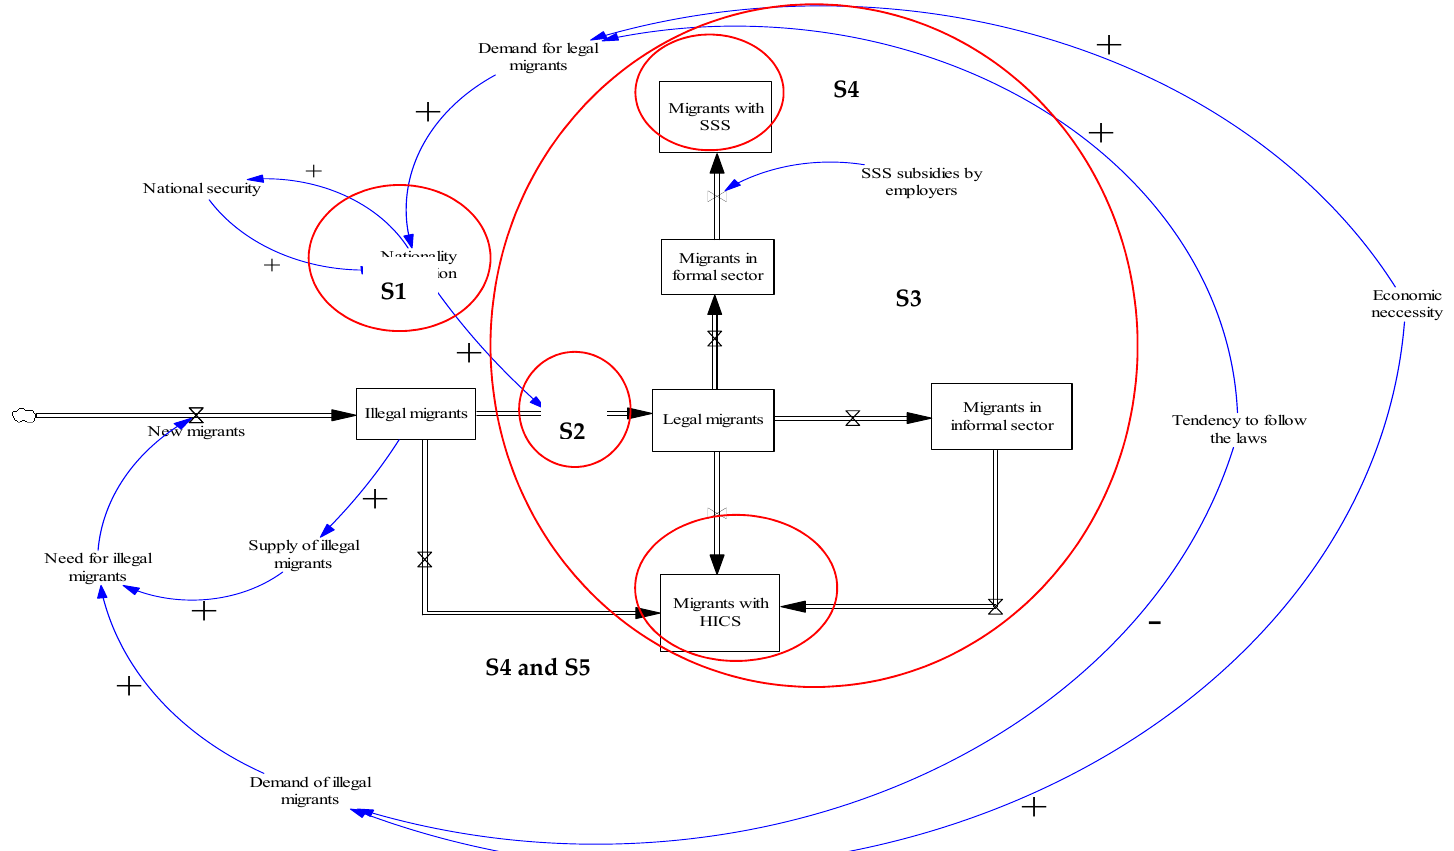
Figure 3. The SFD of the dynamics of the legalisation process and access to health insurance (SSS and HICS) by migrant workers. Note: Subtheme 1: NV process as the most critical step for legalising the precarious status of undocumented migrants. Subtheme 2: Role of private hospitals in health examination before enrolling in the insurance. Subtheme 3: Interim period between enrollment in the SSS and e ff ective activation of insurance. Subtheme 4: Practical problems originating from the di ff erence in the design between the SSS and the HICS. Subtheme 5: Data recording system of the HICS. HICS = Health Insurance Card Scheme; SSS = Social Security Scheme. ( + ) positive influence. (-) negative